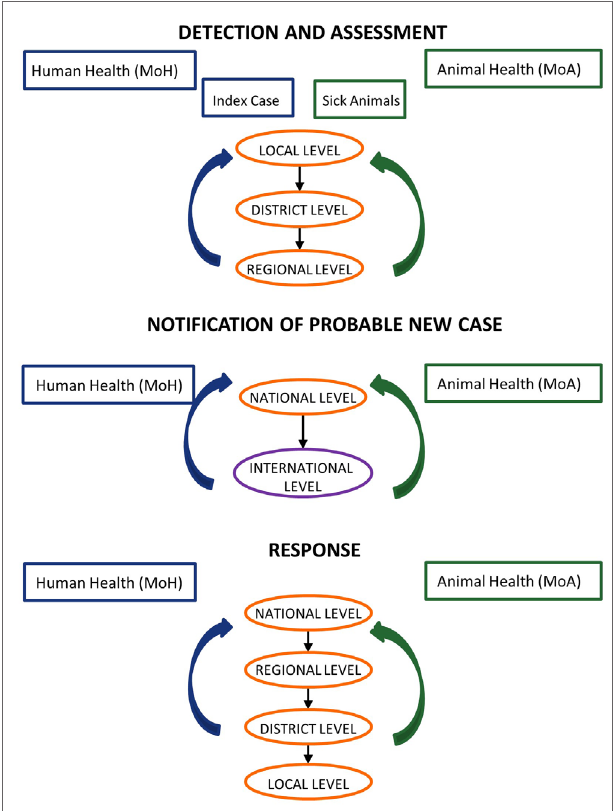
FigUre 1 | Model joint assessment and response . In collaboration with the Jordan Ministry of Health, Field Epidemiology Training Program, and Ministry of Agriculture, we examined coordination and communications from the index case to notification at the national and international levels in order to identify priorities and gaps that limit information sharing for actions. Efforts in surveillance and response lead by Ministry of Health are represented in blue while those lead by Ministry of Agriculture are in